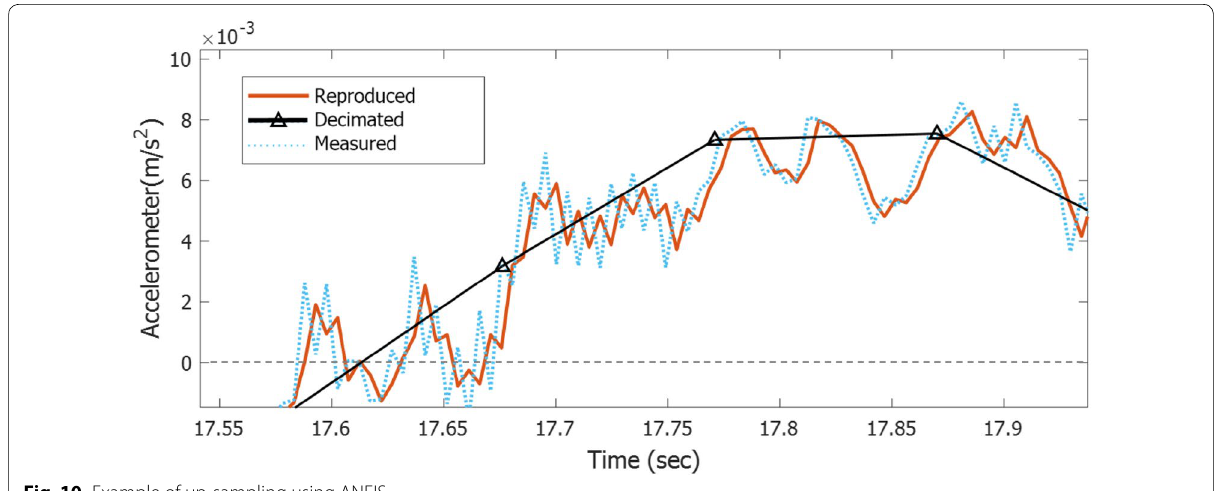
Fig. 10 Example of up‑sampling using ANFIS.